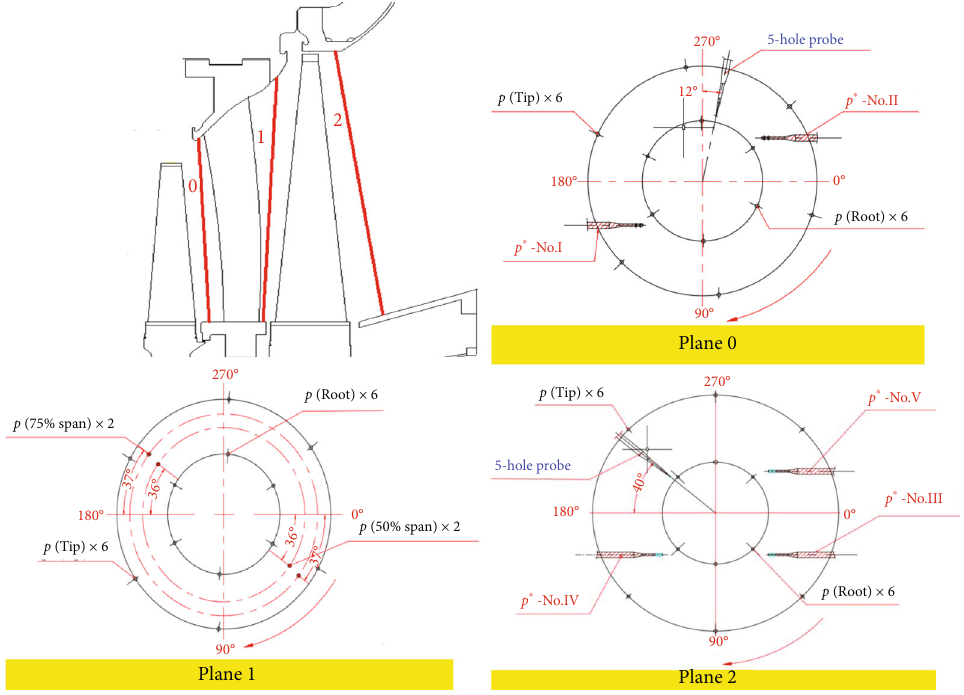
Figure 3: Indication of measurement planes and probe positions. Table 1: Measured parameters and probe